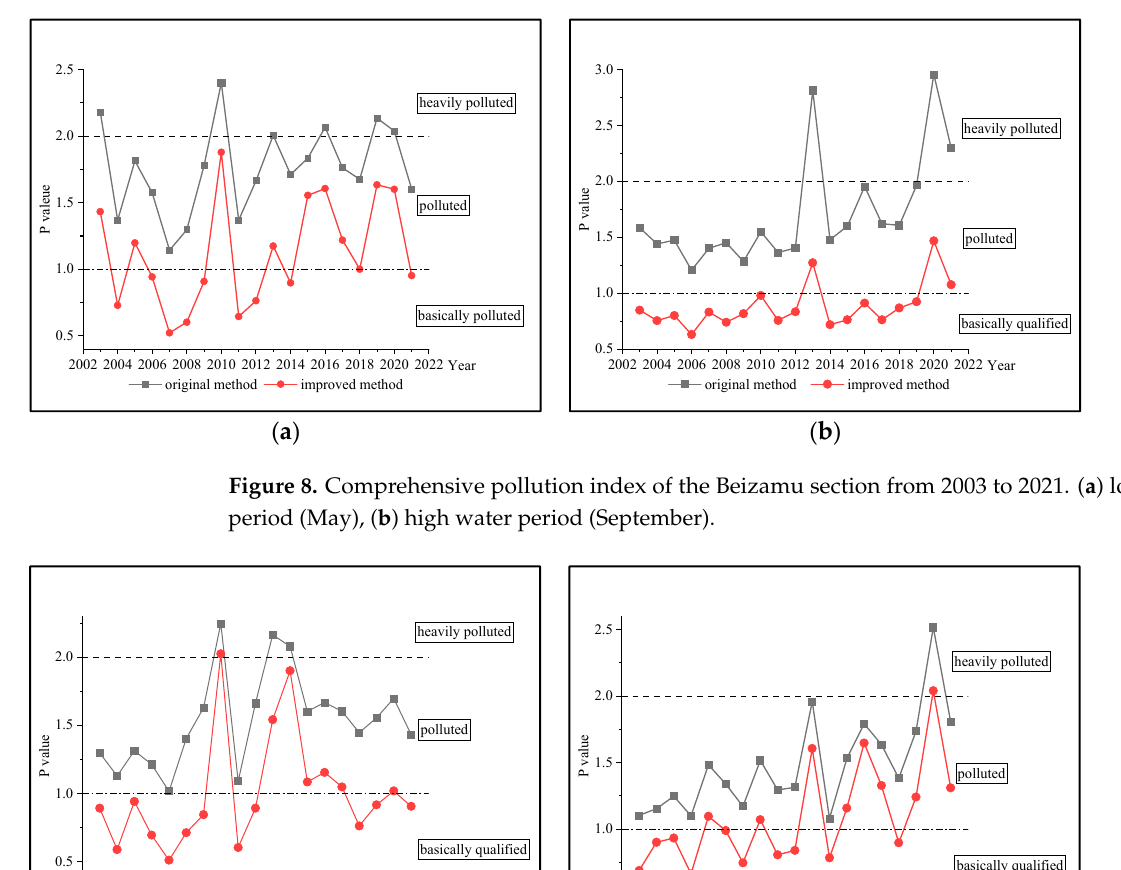
( b ) Figure 7. Water quality evaluation results for each indicator of the Taigou section from 2003 to 2021. ( a ) low water period (May), ( b ) high water period (September).